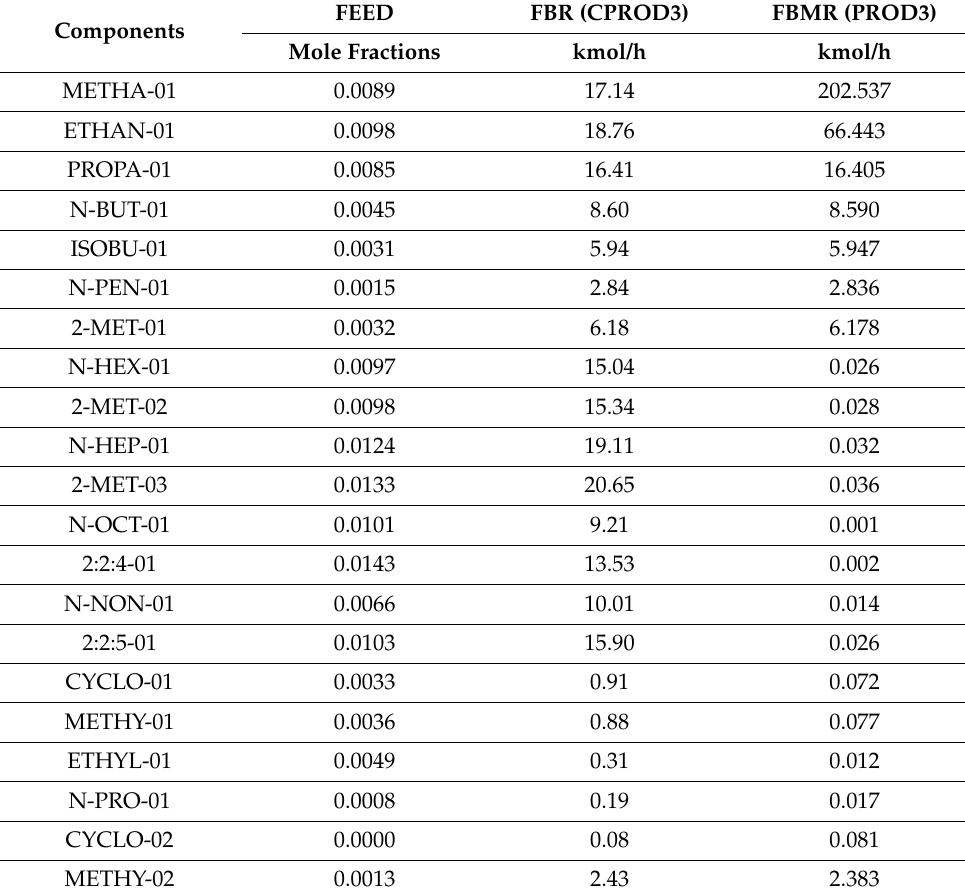
Table 4. Aromatics production in fluidized bed reactor and fluidized bed membrane reactor.